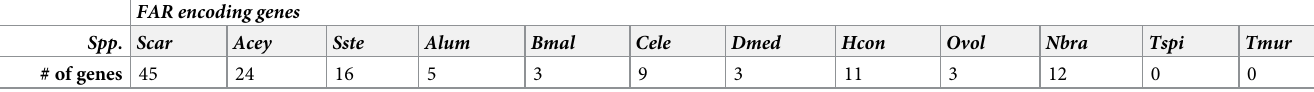
Table 1. Number of putative FAR-encoding genes present in the genomes of various nematode species. Species in order from left to right: Steinernema carpocapsae (Scar), Ancylostoma ceylanicum (Acey), Strongyloides stercoralis (Sste), Ascaris lumbricoides (Alum), Brugia malayi (Bmal), Caenorhabditis elegans (Cele), Dracunculus medinensis (Dmed), Haemonchus contortus (Hcon), Onchocera volvulus (Ovol), Nippostrongylus brasiliensis (Nbra), Trichinella spiralis (Tspi), Trichiuris muris (Tmur). T spiralis and T . muris have no known FAR encoding genes while S . carpocapsae shows the greatest expansion of FAR genes in its genome. FAR encoding genes Spp . Scar